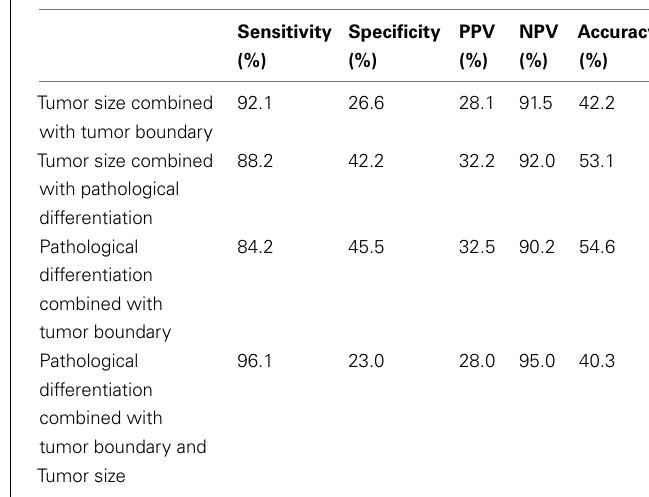
Table 5 | Sensitivity, specificity, positive predictive value (PPV), negative predictive value (NPV), and accuracy of factors significant on multivariate